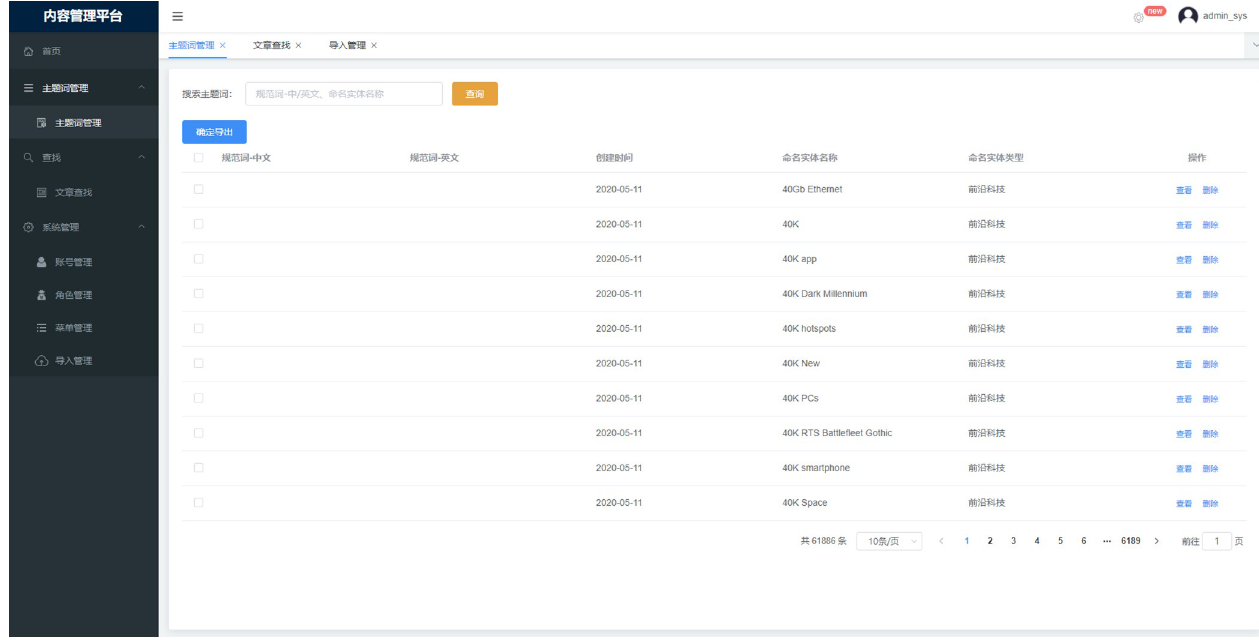
Fig 10. International cutting-edge technology identification subject word management.